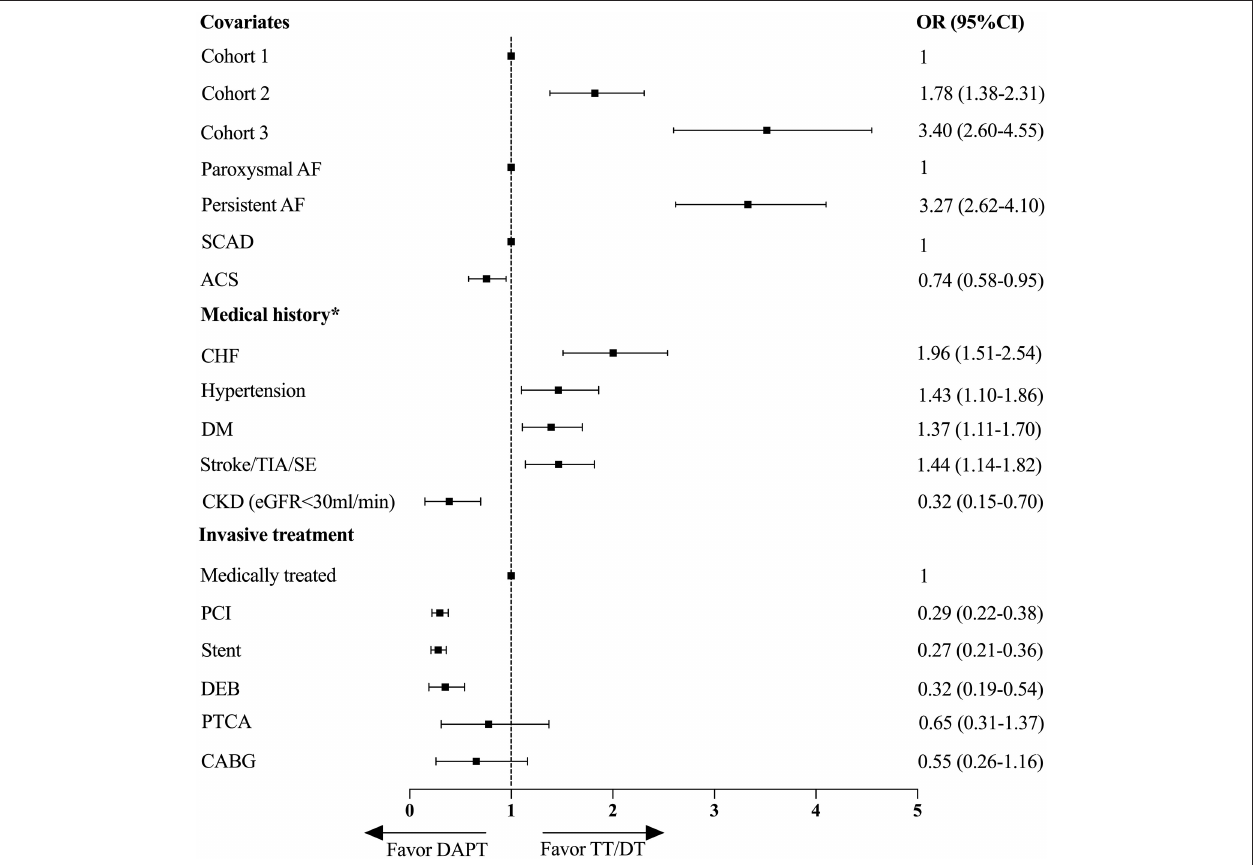
FIGURE 4 | Multivariate logistic regression analysis for factors associated with the prescriptions of TT/DT or DAPT. *Reference group is patient with no medical history or no invasive treatment. OR, odds ratio; CI, confidence interval; DAPT, dual antiplatelet therapy; TT, triple therapy; DT, double therapy; AF, atrial fibrillation; SCAD, stable coronary artery disease; ACS, acute coronary syndrome; CHF, congestive heart failure; DM, diabetes mellitus; TIA, transient ischemic attack; SE, systemic embolism; CKD, chronic kidney disease; PCI, percutaneous coronary intervention; DEB, drug eluting balloon; PTCA, percutaneous transluminal coronary angiography; CABG, coronary artery bypass graft.